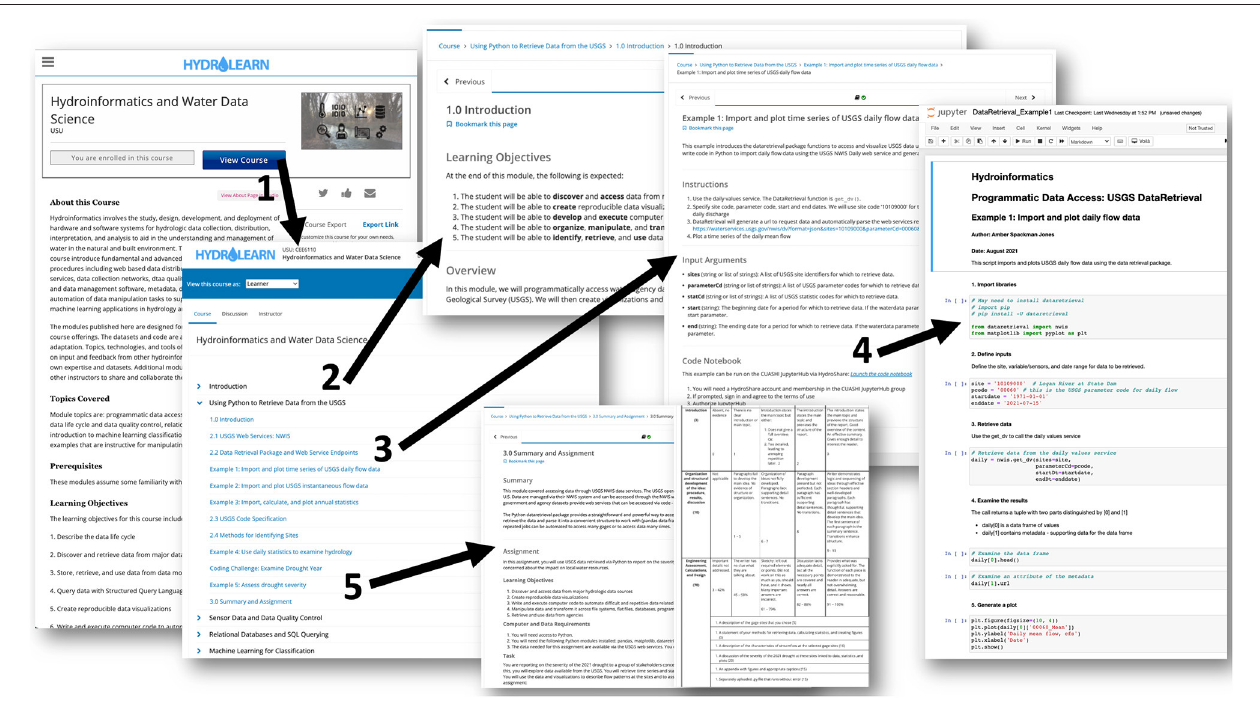
FIGURE 3 | Module implementation in HydroLearn. The numbered steps indicate the order of workflow and the location of essential module elements: (1) the course landing page contains metadata and links to a course outline, (2) learning objectives in the module introduction, (3) the narrative consists of text, links, images, tables, and code snippets, (4) code examples are interactive notebooks in the CUAHSI JupyterHub linked from HydroLearn, and (5) the technical assignment and associated rubric are a separate module